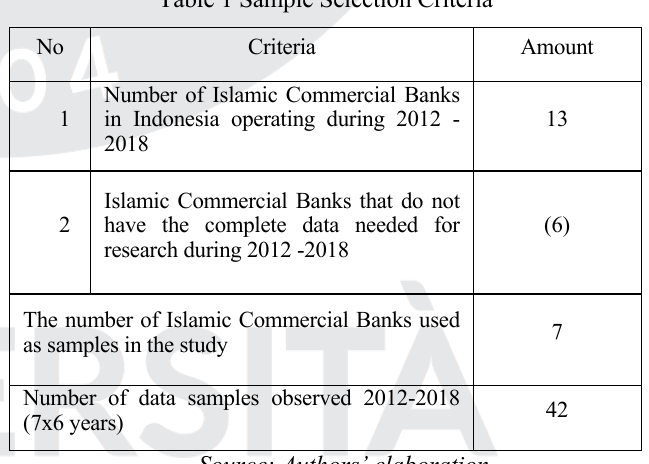
Table 1 Sample Selection